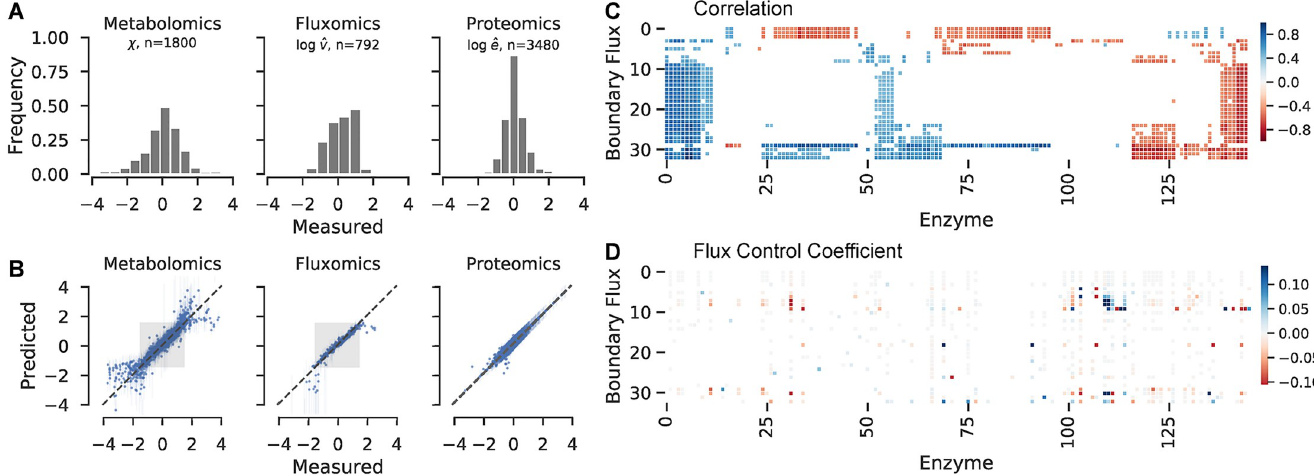
Fig 4. Parameterizing a genome-scale kinetic model with multiomics data. (A) Distributions in log-transformed (unitless) experimental data after normalizing with respect to the phosphate-limited reference state. (B) Posterior predictive distributions after fitting with ADVI. Higher weight was given to experimental datapoints close to the reference state ( ± 1.5) as indicated by the gray boxes. (C) Heat map of correlation coefficient between experimental enzyme measurements (x-axis) and experimental boundary flux measurements. Boundary fluxes and enzymes are sorted with hierarchical clustering. (D) Heat map of FCC as estimated from posterior parameter distributions. Boundary flux and enzyme ordering match those determined in (C). Colors represent medians of the posterior predictive distributions, FCCs with a direction that could not be confidently determined are colored white.